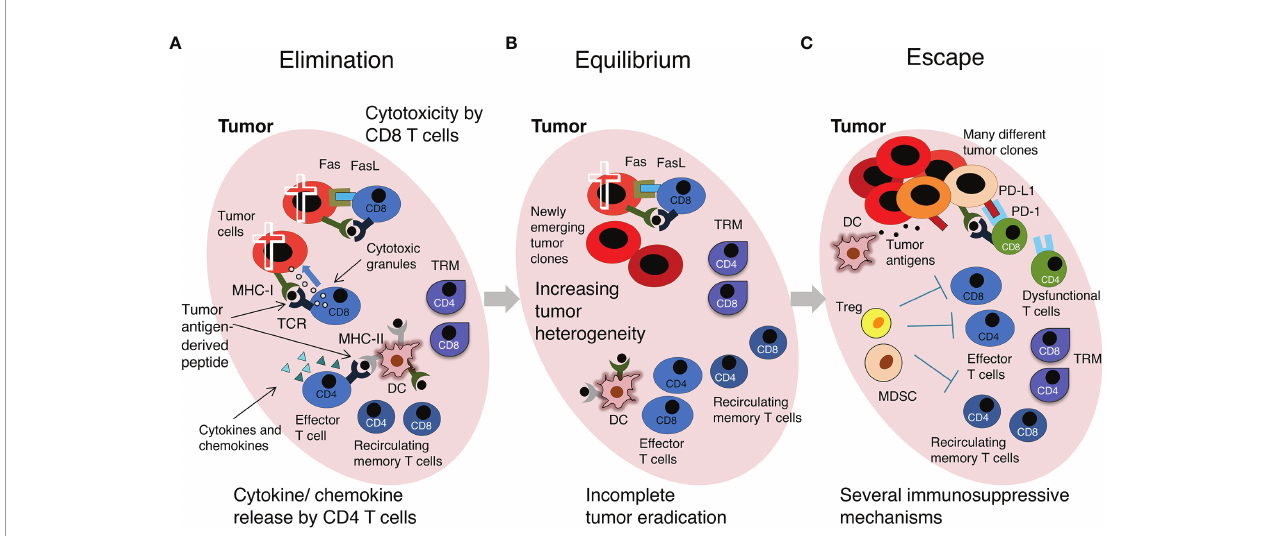
FIGURE 2 | The “ Cancer Immunoediting ” concept: effector versus exhausted T cells. A scheme of the 3 phases of “ Cancer Immunoediting ” is represented, with emphasis on T cells. (A) Elimination. The tumor has low heterogeneity. Effector CD8 T triggered by recognition of tumor-derived peptides in the context of MHC-I molecules on the surface of tumor cells kill these cells by release of secretory granules (containing perforin, granzymes, etc.) and FasL/Fas interaction. Effector CD4 T cells triggered by recognition of tumor-derived peptides in the context of MHC-II molecules on the surface of DCs and other tumor-in fi ltrating immune cells release cytokines and chemokines. (B) Equilibrium. There is moderate intratumoral heterogeneity, and tumor mass contains some genetically different tumor clones. TILs control tumor growth without inducing tumor regression. (C) Escape. Tumor is genetically unstable and highly heterogeneous. The immune cell in fi ltrate contains a few effector T cells and high levels of regulatory T cells (Tregs) and Myeloid Derived Suppressor Cells (MDSCs), which contribute to create an immunosuppressive environment. DCs do not effectively present tumor-derived antigens and T cell-inhibitory circuits are dominant, for example that induced by the interaction between PD-L1 + tumor cells and PD-1 + T cells. Most intratumoral T cells are dysfunctional. The tumor grows. For simplicity, only some cells are depicted. See text and original reference (9) for more